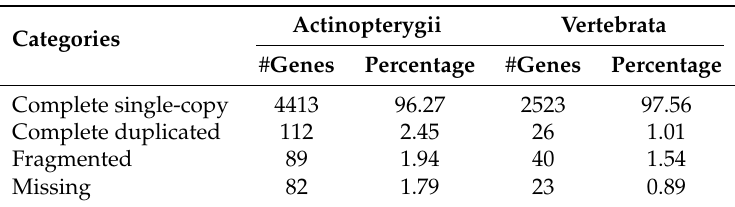
Table 1. Summary statistics of Benchmarking Universal Single-Copy Orthologs (BUSCO) analysis for Sander lucioperca genome